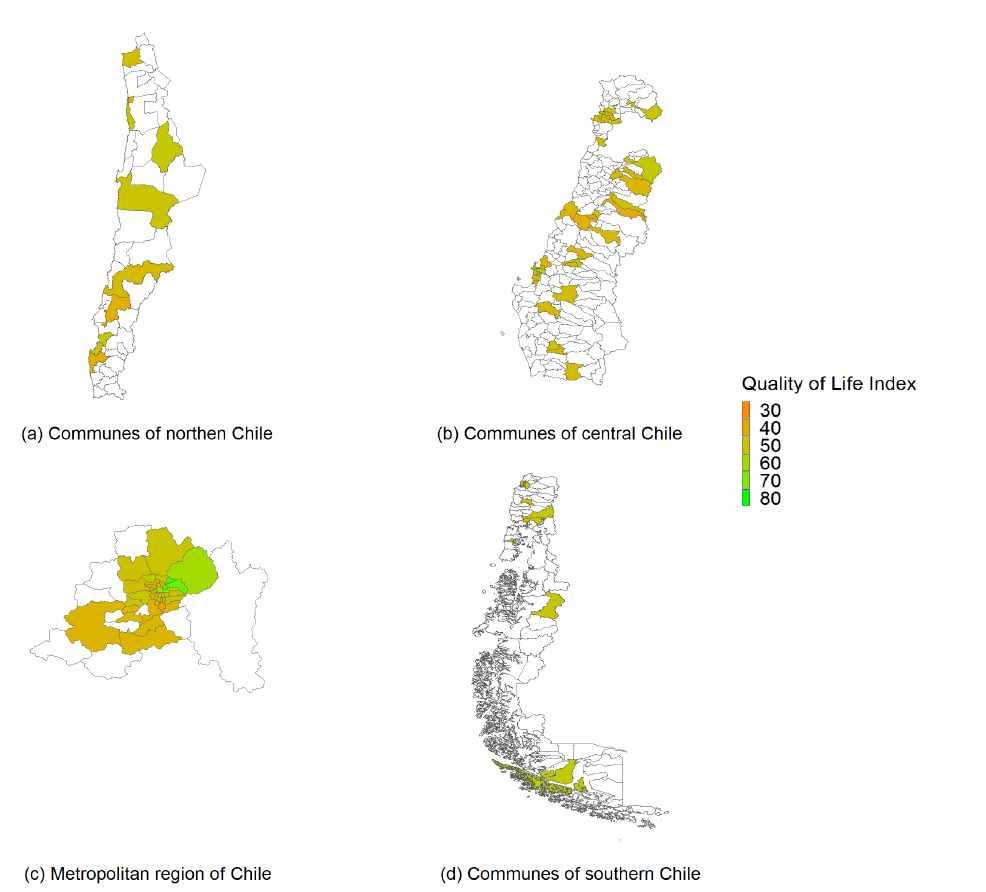
Figure 1. Map of Chile by commune with urban life quality